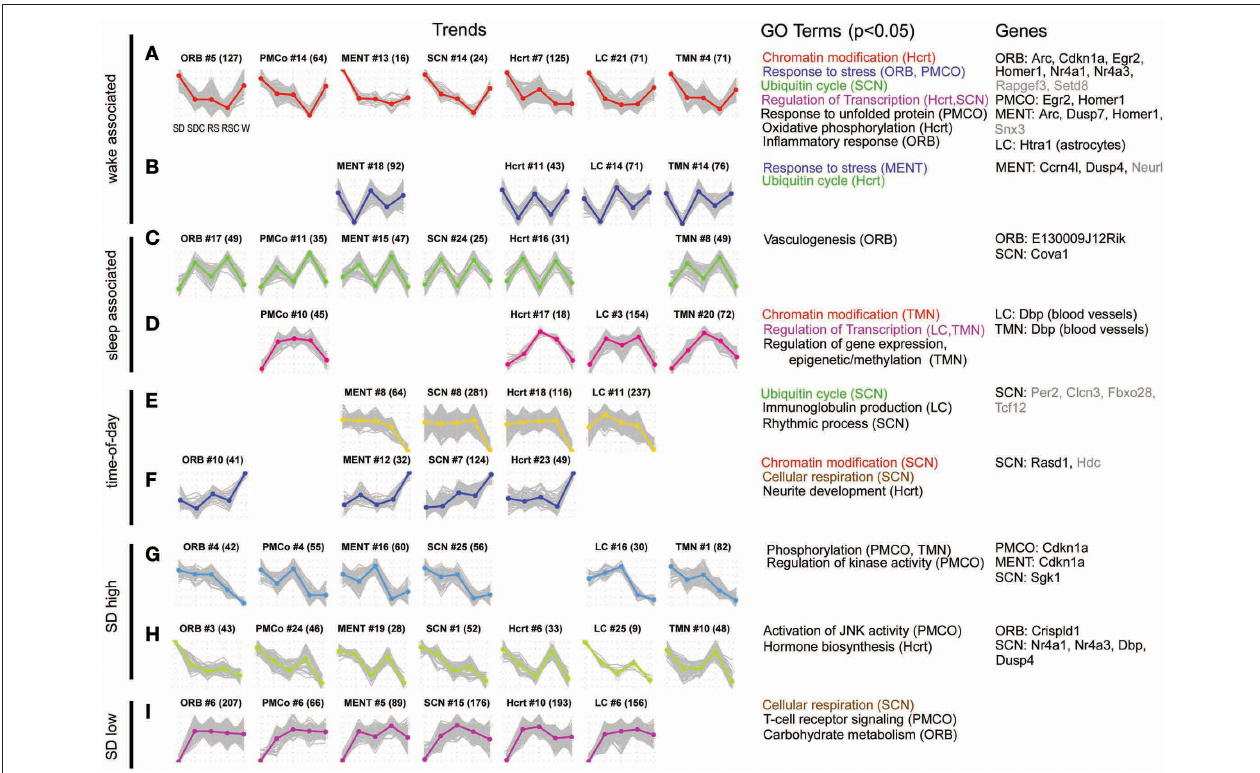
vectors (plotted as gray lines in (A–i) ]. In order to compare similar trends across brain regions, the 175 expression trends were hierarchically clustered (not shown), and 48 of 175 trends are shown (A–i) . At the top of each individual trend plot, the structure name and cluster number are shown with the number of genes within each cluster in parentheses. Gene ontology (GO) terms which were enriched in a gene cluster (DAVID, p < 0.05) are shown (structures exhibiting those terms are listed in parentheses). Color-coding of GO terms shows terms that are shared across multiple trend types. The right-most column lists examples of genes which have been validated by ISH for each structure either in the original ISH screen (gray font), or with triplicate data (black